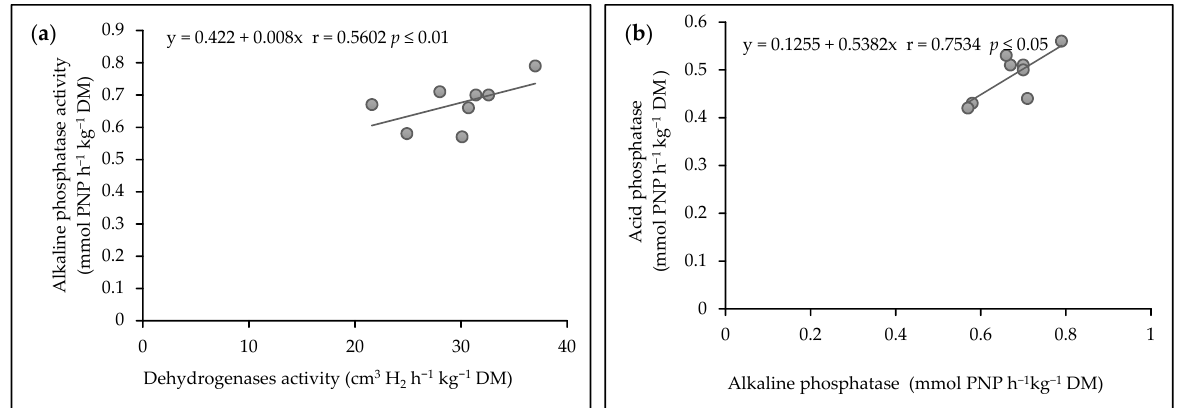
Figure 6. ( a ) The correlations between dehydrogenases activity and alkaline phosphatase activity, ( b ) alkaline phosphatase activity and acid phosphatase activity. Table 8. Total organic carbon in soil (in